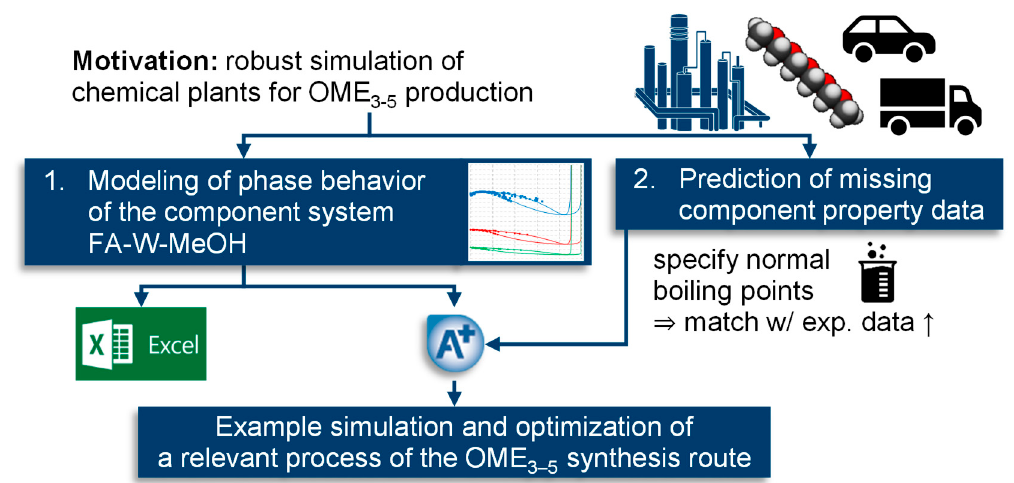
Figure 2. Illustration of the research approach followed in this paper.